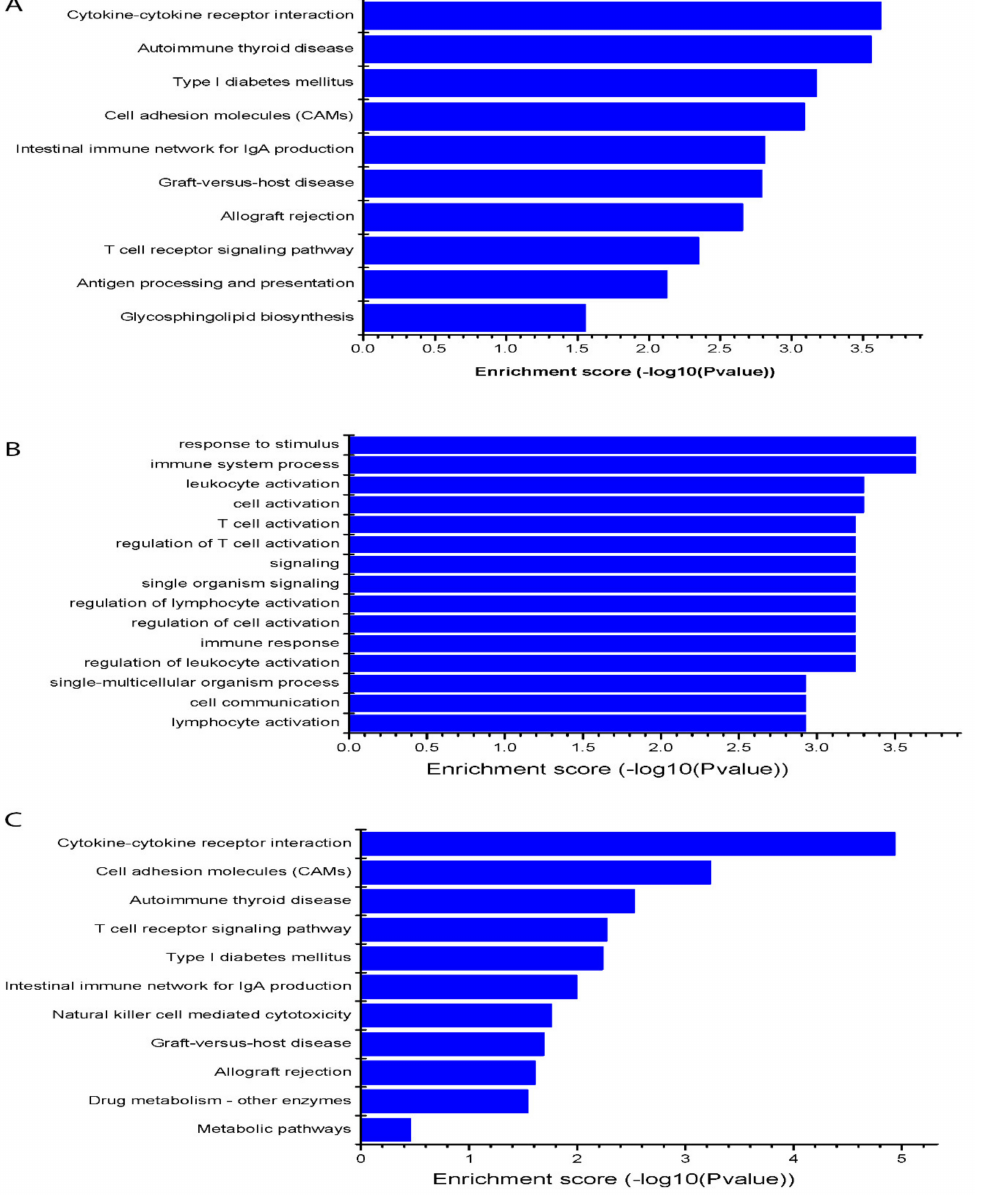
Figure 3. KEGG pathway analysis of target pathways of differentially expressed platelets lncRNAs and target gene prediction of a novel lncRNA. ( A ) The most enriched pathway among up-regulated and down-regulated mRNAs. ( B ) GO enrichment score graph of target genes of lnc_1285 as regards biological processes. ( C ) KEGG pathway analysis of target genes of